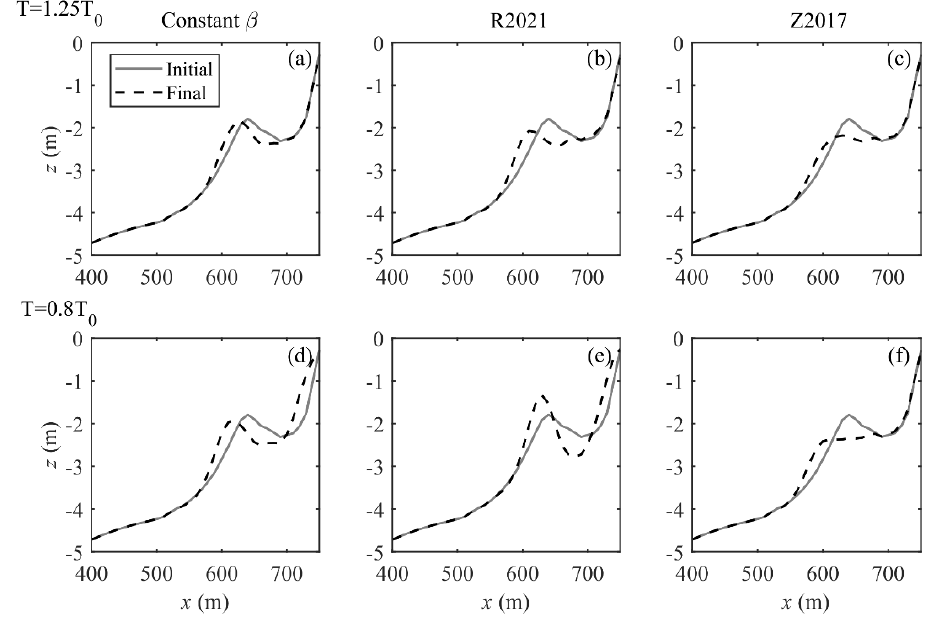
Figure 8. Comparisons of beach profile predicted by constant roller slope ( a , d ) and the roller slope of R2021 ( b , e ) and Z2017 ( c , f ) under two different wave periods. Figure 8a–c are calculated with T = 1.25 T 0 , and Figure 8d–f are calculated with T = 0.8 T 0 .